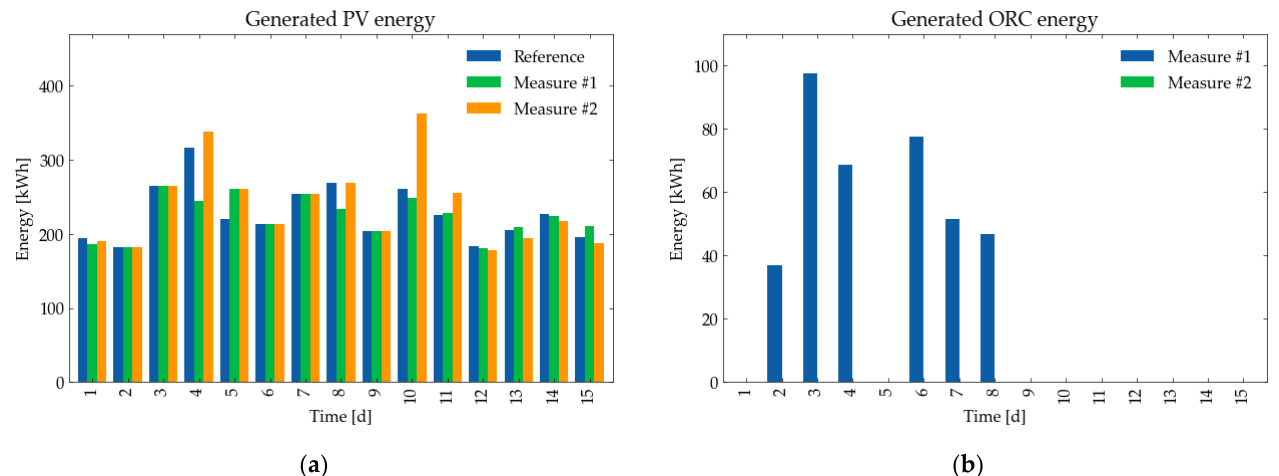
Figure 16. Daily energy amounts injected for each proposed measure by ( a ) PV and ( b ) ORC systems.